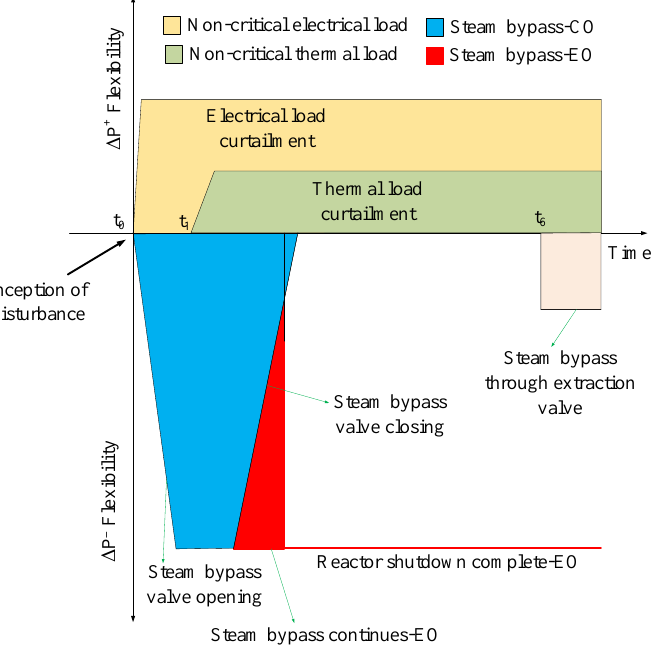
Figure 6. Activation of new assets during